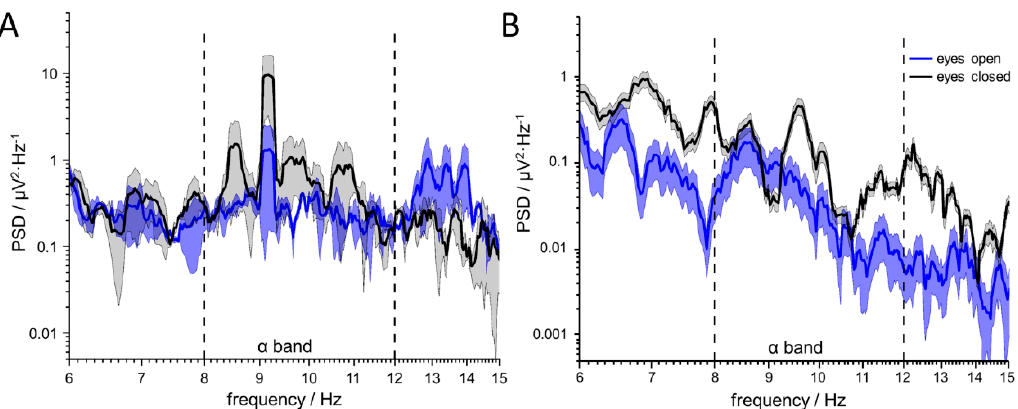
7 of 12 Figure 4. Cyclic voltammetry measurement. ( A ) Smooth platinum electrodes before and after electrochemical deposition of porous platinum (mean of 10 electrodes each). ( B ) Comparison of the charge delivery capacity (CDC) of MP35N (N = 7), Ag/AgCl (N = 7), smooth and porous platinum (pPt) electrodes (N = 10 each) of the same geometric area. Mean and standard deviation. 3.3. Ear-EEG Measurment A promising application for the greatly enlarged electrode surfaces is the recording of biological signals in contact with the skin. As proof of principle, the EEG signals were recorded at the auricle and in the ear canal. Two pairs of ear EEG electrodes were made for one person, one with platinum-copper alloy and one made of chlorinated silver foil. The ear molds were easy to use and can be inserted by the individual independently. Towards a real-world scenario of the platinum electrodes, external reference and counter electrodes, e.g., on the lobulus, Cz, or low mastoids have been omitted. The data refer exclusively to measurements from four electrodes within the auditory canal referenced to the electrodes in the concha on the same side of the head. To check the functionality, the Berger effect was measured in a shielded EEG laboratory without external disturbances, where the test person kept the eyes open and closed for 30 s each. In both conditions the power of the alpha-waves—a frequency band between 8 − 12 Hz changes [31]. At rest and with closed eyes, these waves can be derived from the entire scalp, originated in a synchronization of both brain hemispheres. When the eyes are opened, the synchronization disappears and a blockage of the alpha-rhythm occurs. A successful differentiation of the frequency spectra in the alpha band [8 − 12 Hz] was possible with both materials, whereas conductive gel had to be used with silver/silver-chloride electrodes while measurements with the porous platinum electrodes were conducted in a dry condition. Furthermore, for the measurements with the silver electrodes, the low mastoid on the same side of the head was used as a reference. The mean values and standard deviations of the frequency spectra across all four electrodes in the auditory canal show an increase in power in the alpha band when the eyes were closed (Figure 5). Thus, on average, an increase in power of 2.4 ± 1.8 µV² can be expected for chlorinated silver electrodes and 4.5 ± 3.7 µV² for porous platinum electrodes. The high variances reflect the different electrode performances. For example, a selected electrode with a ratio of up to 4.4 can